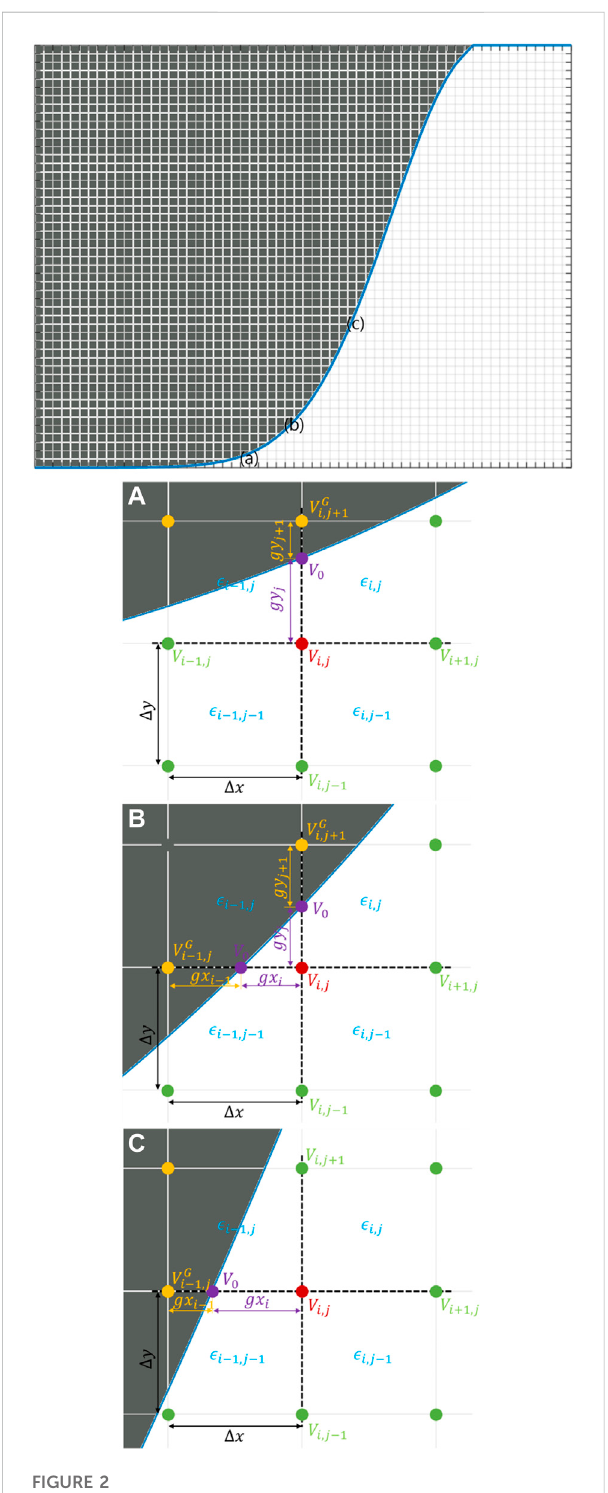
FIGURE 2 Aschematicofthe fi eldsolverwithcurvedboundarieslocated (A) at the upper side, (B) at the upper left sides, and (C) at the left side, which corresponds to the number of ghost grids (purple dots) of 1 (top), 2 (top and left), and 1